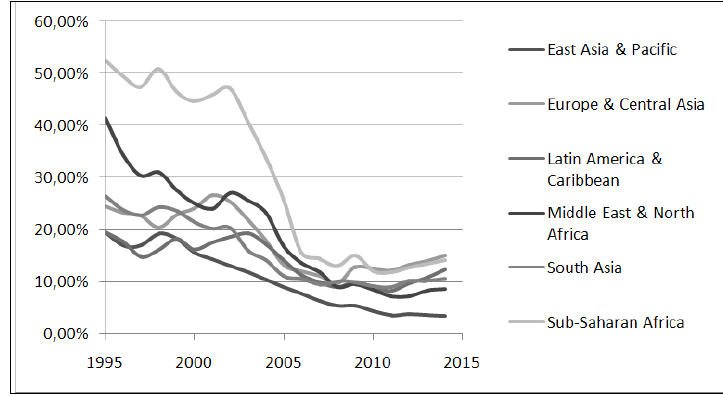
Fig. 6. Trends in PPG external debt to GDP region-wise